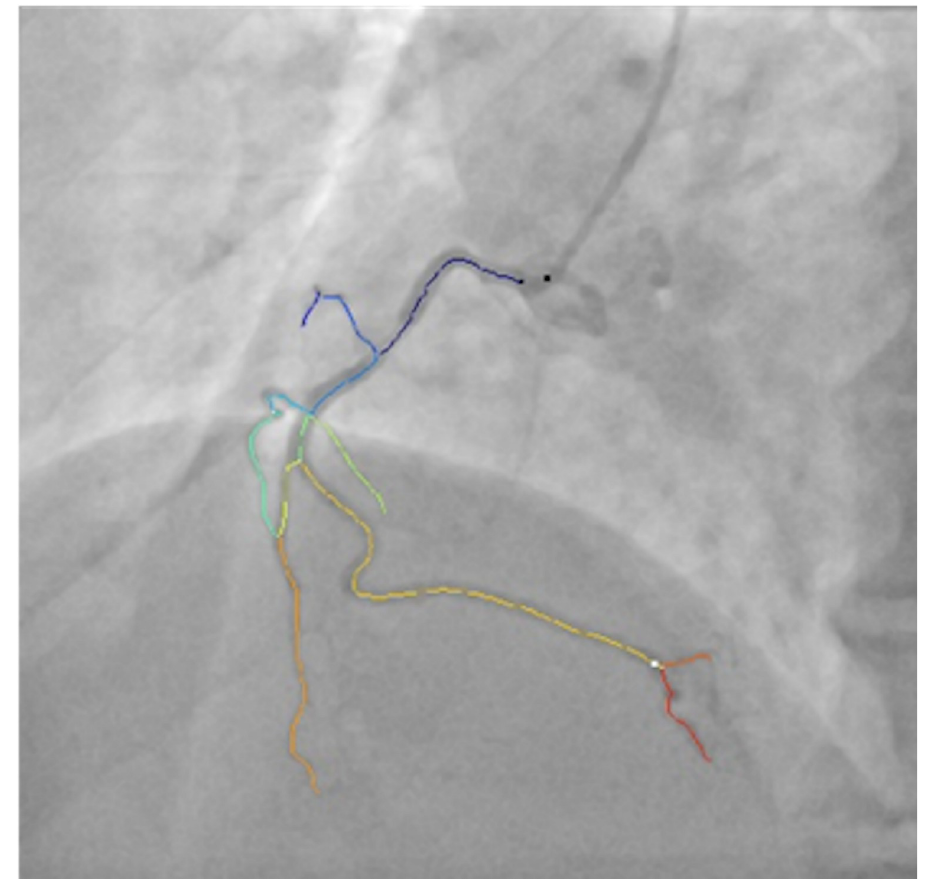
Fig 2. Sample envisaged detection of the distal point (white circle) for a right coronary artery image. The black circles the catheter tip.